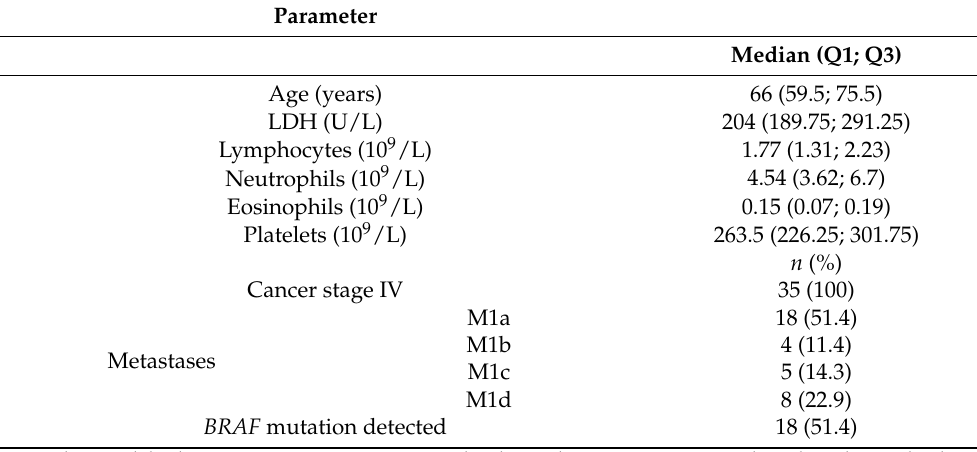
Table 1. Clinical characteristics of melanoma patients participating in the study ( n =